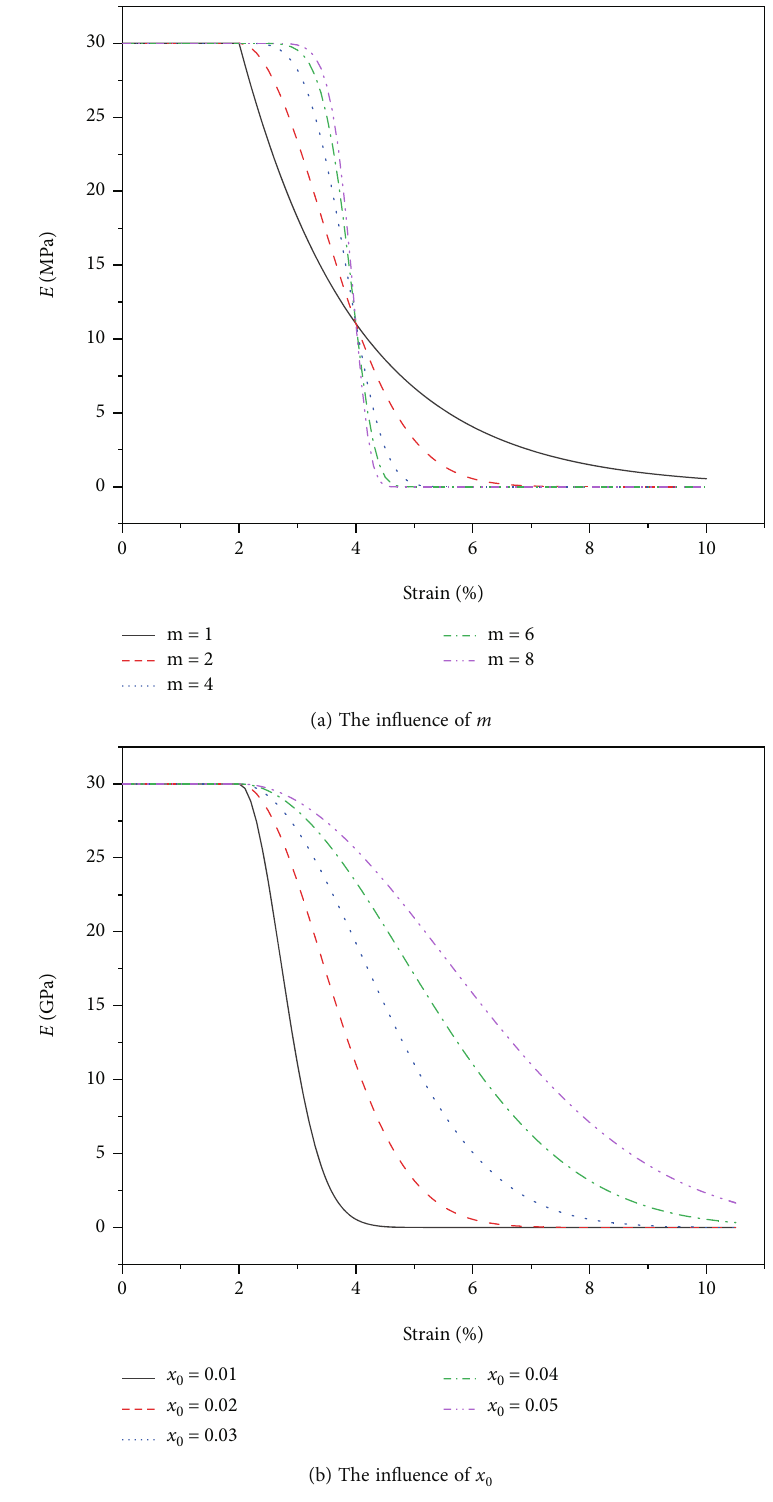
Figure 3: E ff ects of m and x 0 on the relationship between elastic modulus and